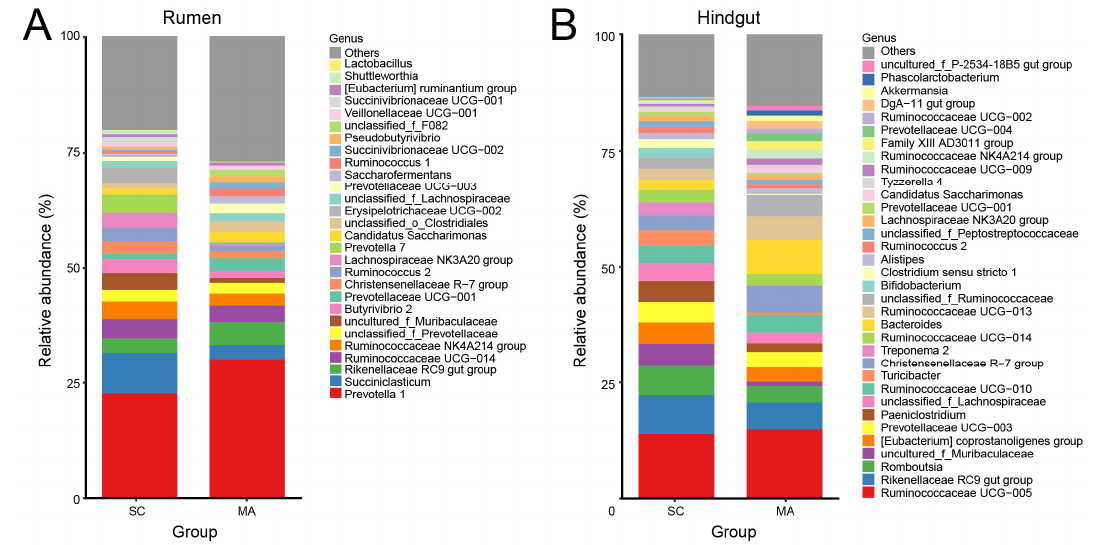
Figure 3. Bar plot of observed bacterial genera with a relative abundance >1% in the ( A ) rumen and ( B ) hindgut from the high-somatic-cell-counts cows with healthy patterns (SC) or with mastitis patterns (MA).